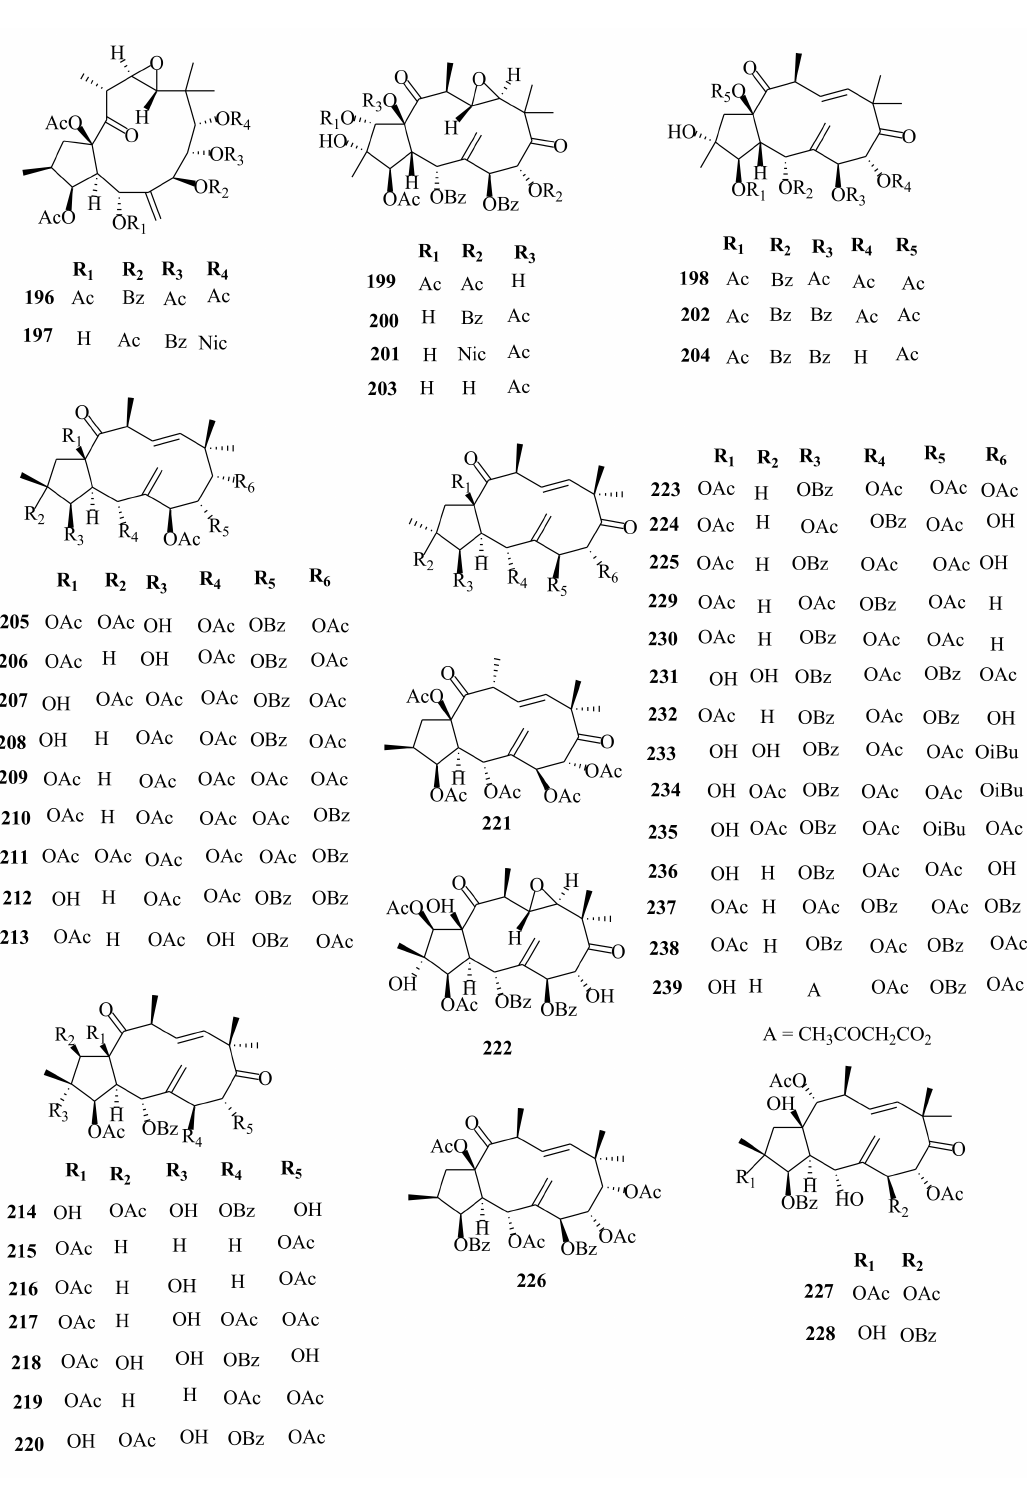
Figure 9. Chemical structures of Euphorbia jatrophane